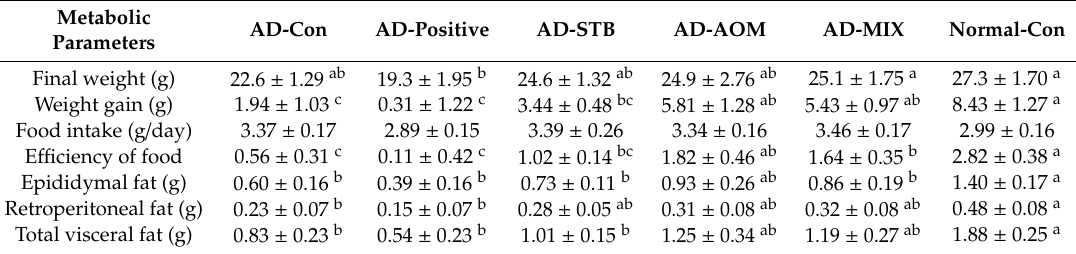
Table 1. Body composition and food intake at the end of experimental